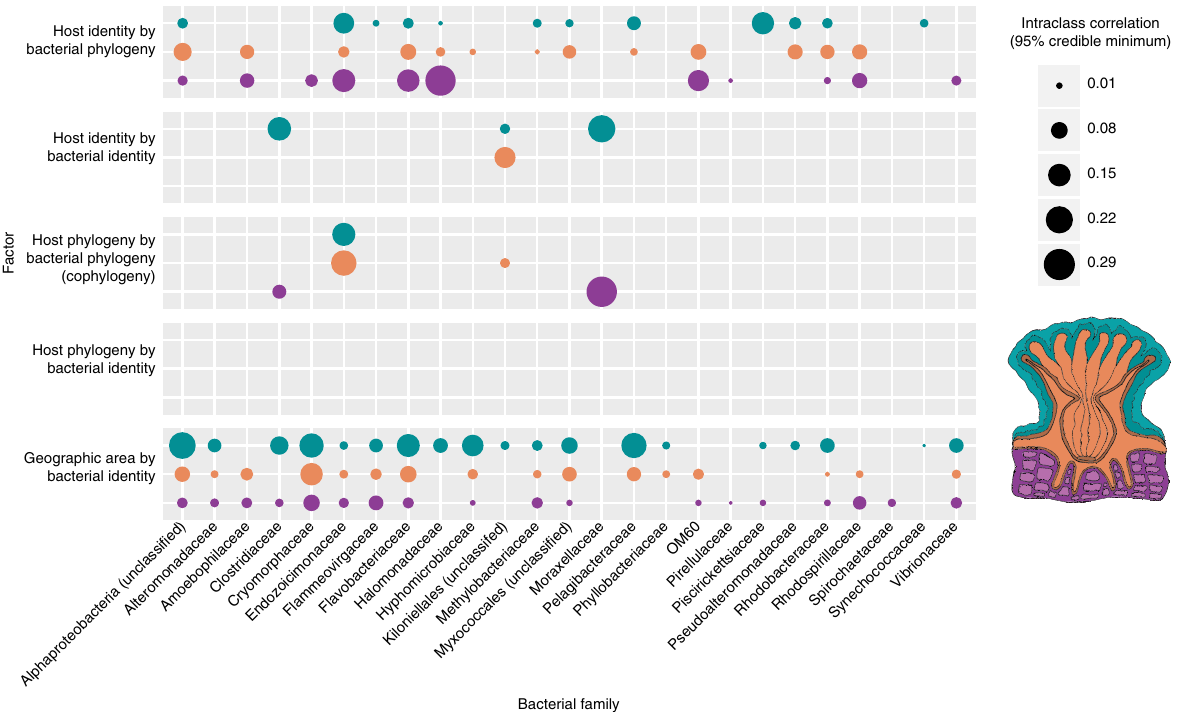
Fig. 3 Effects of host identity, phylogeny, and cophylogeny on bacterial families. Results are derived from co-phylogenetic GLMM analysis within prevalent bacterial families, and incorporate geographic area, bacterial and coral host identity, and bacterial and coral host phylogeny (see Methods and work fl ow in Fig. 1). Each block of rows corresponds to a factor in the model (main effects are not shown). Each row within a block corresponds to a tissue compartment (teal = mucus, orange = tissue, and purple = skeleton; see coral polyp illustration), while each column corresponds to an independent model fi t for the speci fi ed microbial group. Dots were plotted only for ‘ signi fi cant ’ factors (ICC lower bound > 0.01). The size of each dot represents the intra-class correlation coef fi cient (ICC) 95% credible lower bounds from co-phylogenetic linear model analysis. While coral host identity is associated with bacterial phylogeny for most prevalent bacterial families (top block of rows), only 4 bacterial families show co-phylogeny with corals (middle block of